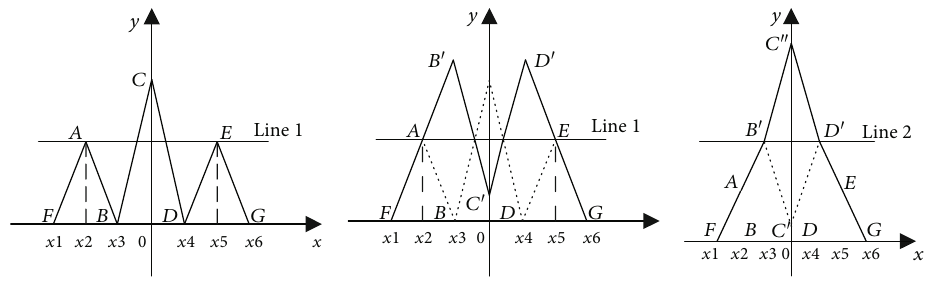
Figure 11: Enfoldment process of the SEA